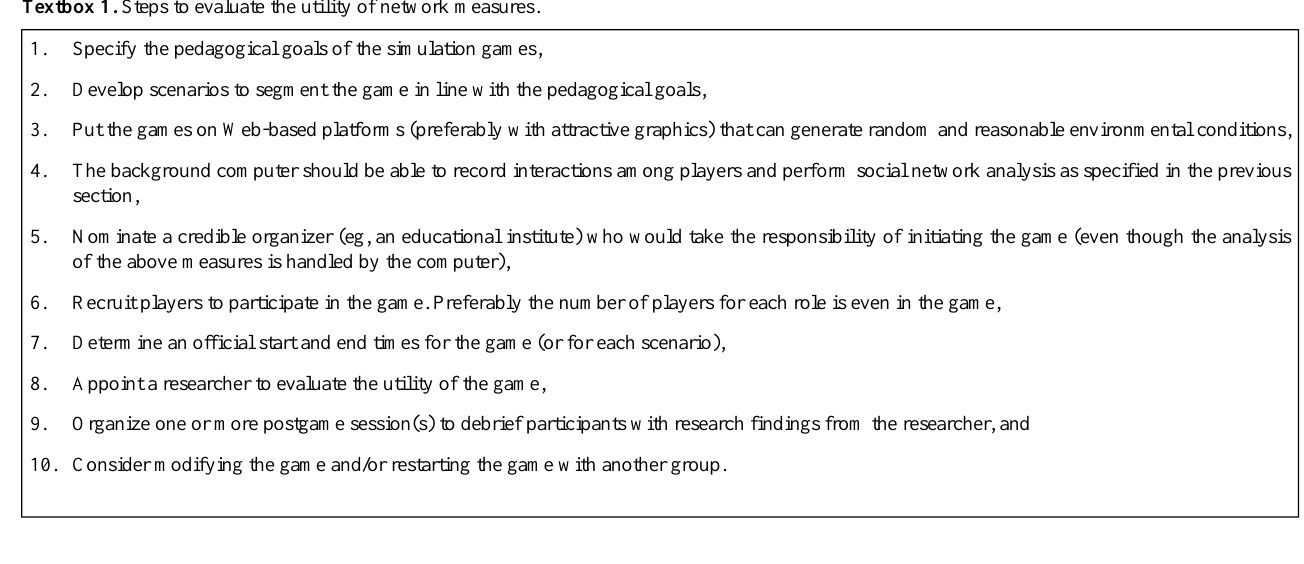
Table 2. Knowledge- and affection-based benefits of online games augmented by network density and diversity.